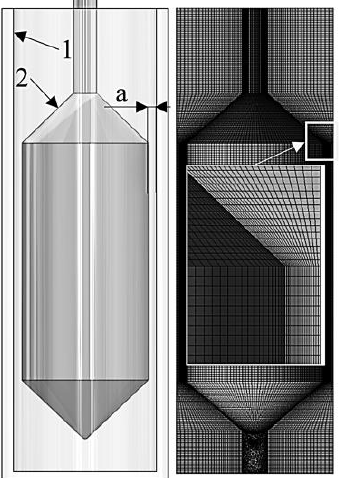
Fig. 5. The solved region and the computational